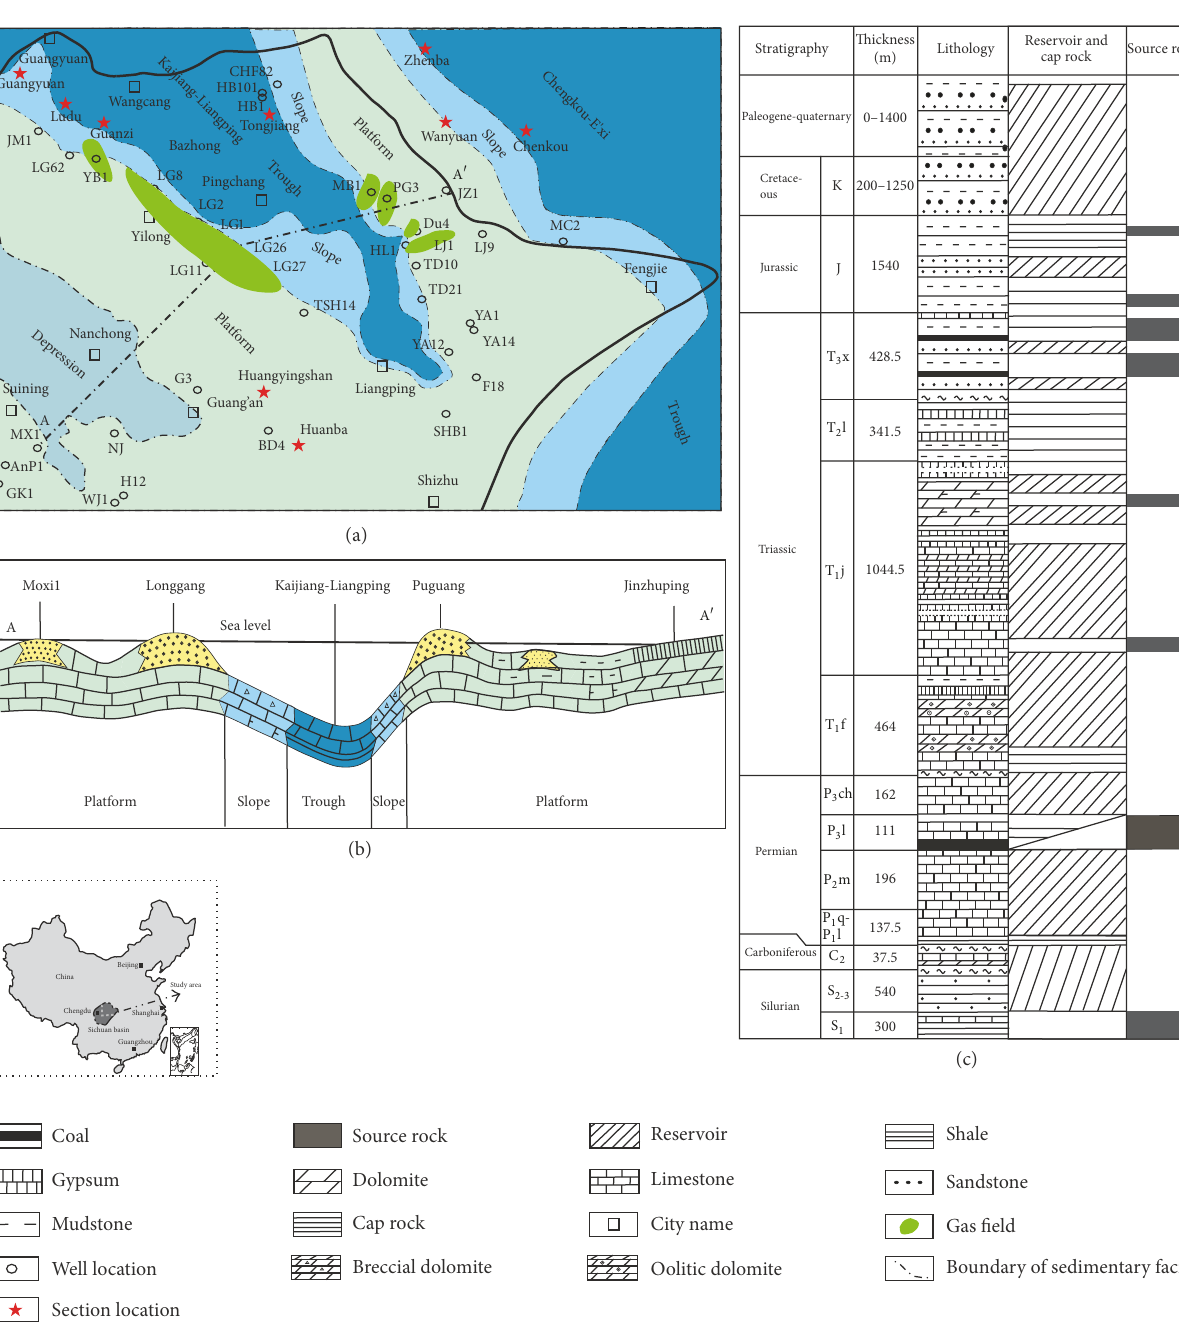
shallower during the period of middle and upper Longmaxi with lower TOC